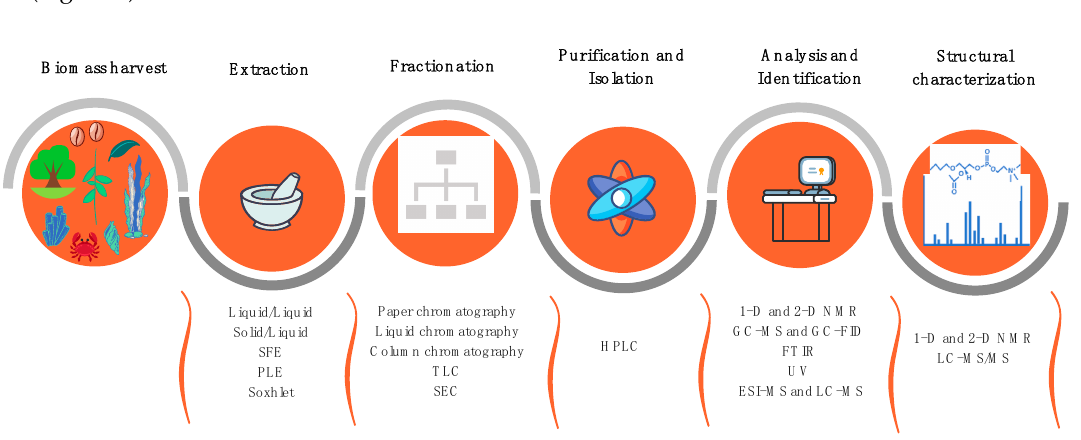
Figure 3. Workflow summarizing the main techniques used for lipidomics analyses of lipids from plants and marine organisms.